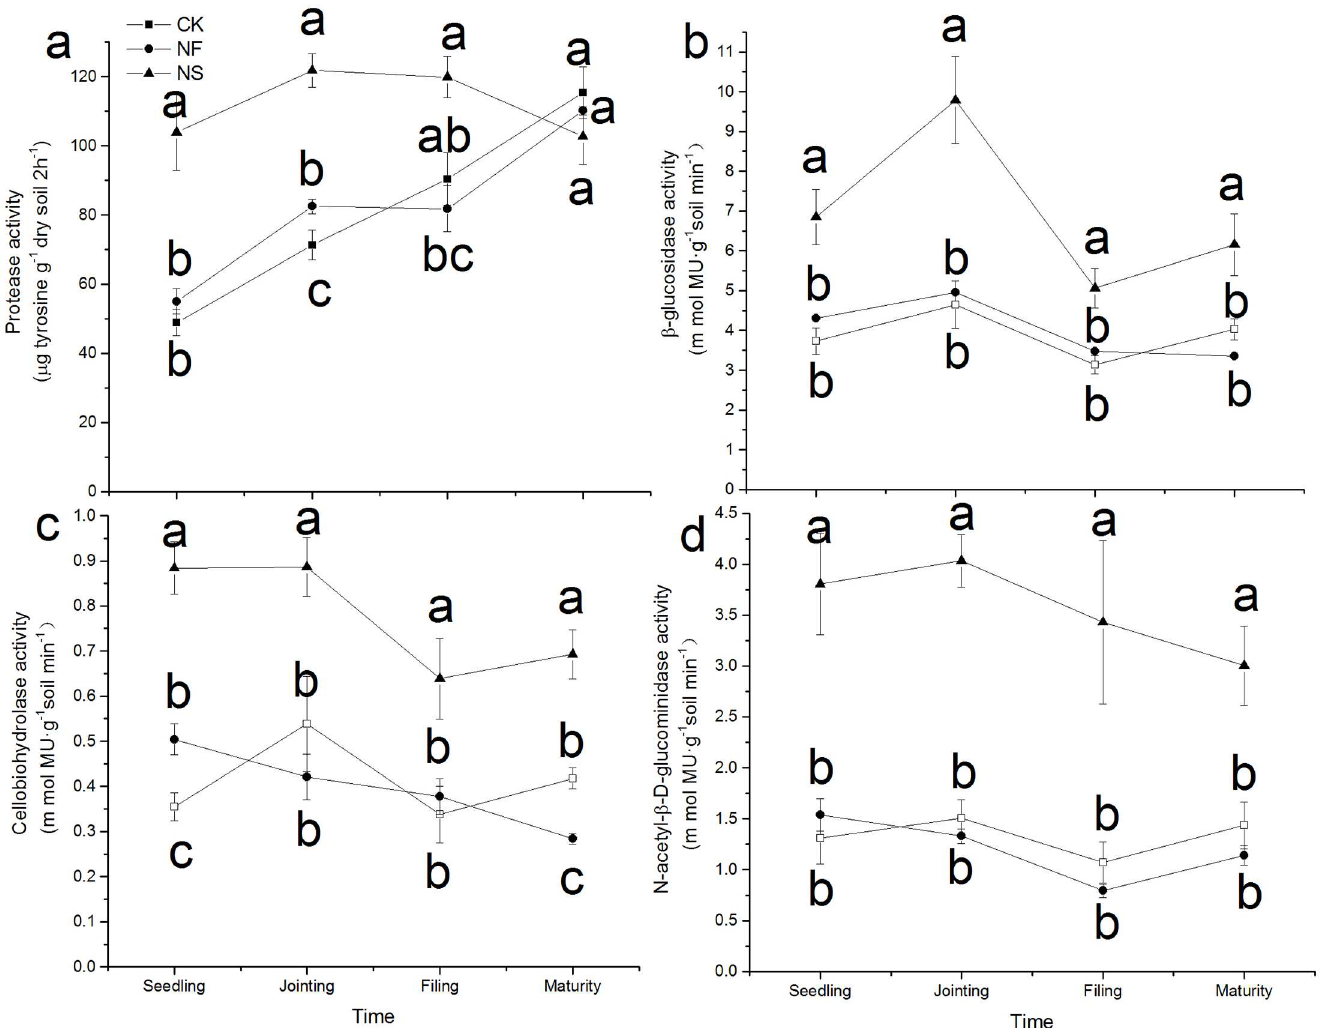
Fig 2. Potential enzyme activities as affected by different treatmentsat 4 sampling dates in the pot experiment. Data points represent the mean of four replicates and error bars are the standard deviationof the mean. The three treatments are: CK, control; NF, (NH 4 ) 2 SO 4 ; NS, (NH 4 ) 2 SO 4 + rice straw. Different letters at each samplingdate indicatea significantdifference betweendifferent treatments at P <